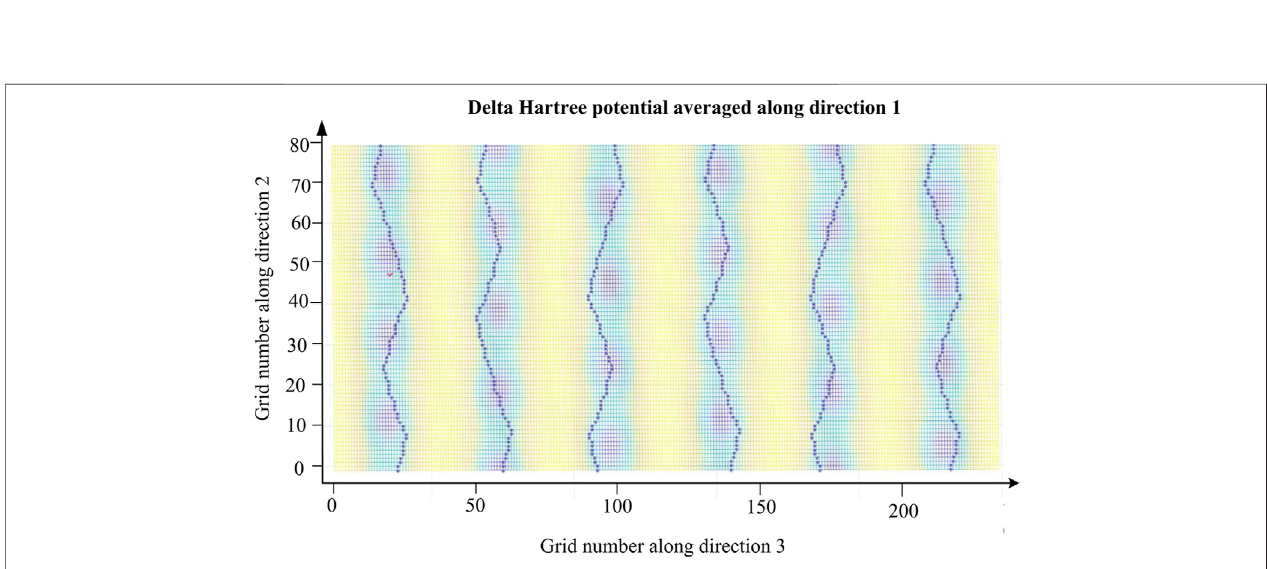
FIGURE 7 | 2D potential energy plot of Li 0.9 Al 0.1 Ni 1/3 Co 1/3 Mn 1/3 O 2 . Blue marks “ * ” represent the paths of electrons, and each marked route is not the same.